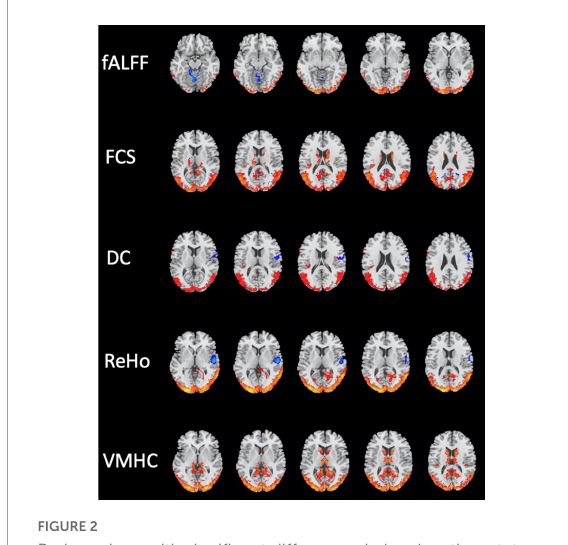
FIGURE2 Brain regions with significant differences in local resting-state functional magnetic resonance imaging (rs-fMRI) measures between the mild traumatic brain injury (mTBI) and healthy controls (HCs) groups (two-sample t -test, GRF-corrected, voxel-level p < 0.001, cluster-level p < 0.01).